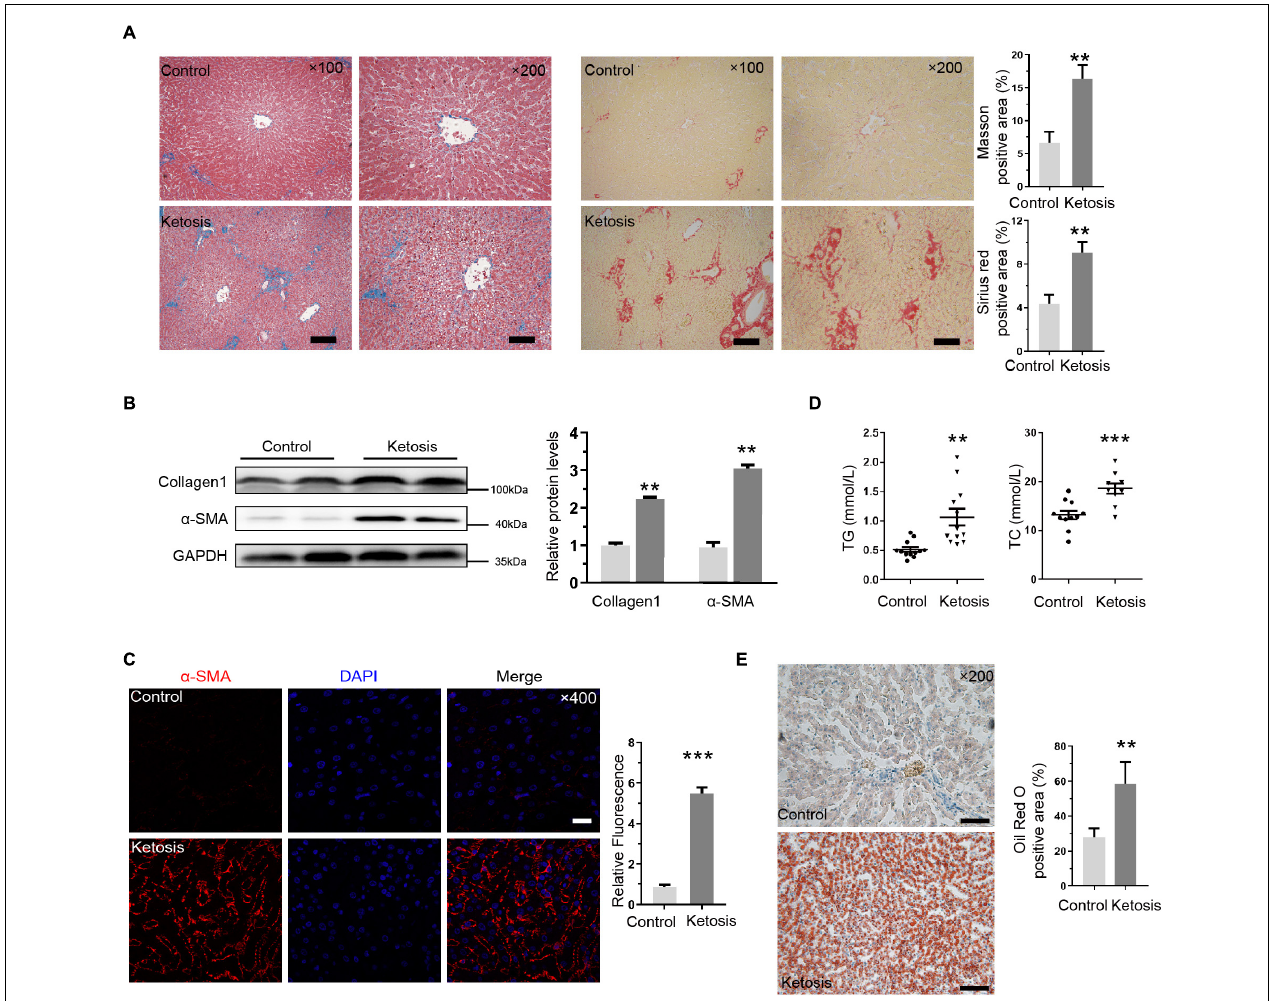
FIGURE 2 | Liver injury induced by ketosis exhibited fibrotic response. (A) Shown are photomicrographs of sections stained with Masson (blue) and Sirus red (red). Fibrillar collagen networks were quantified in right panel. (B) Protein expression of Collagen1 and α -SMA was measured by Western blot, and quantitative analysis was shown in right panel ( n = 4). (C) Immunofluorescence for α -SMA activation in liver tissues extracted from ketotic cows. (D) Concentration of TG and TC ( n = 10–15). (E) Typical pictures of oil red O staining and quantitative image analysis data. Data are reported as mean ± SEM. ** P < 0.01, *** P < 0.001.